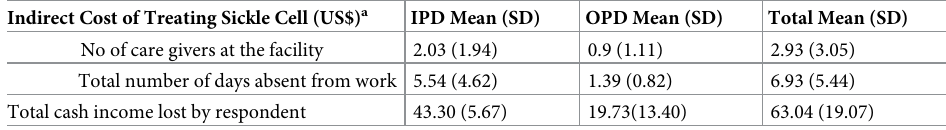
Table 3. Indirect cost of SCD per month reflecting unit